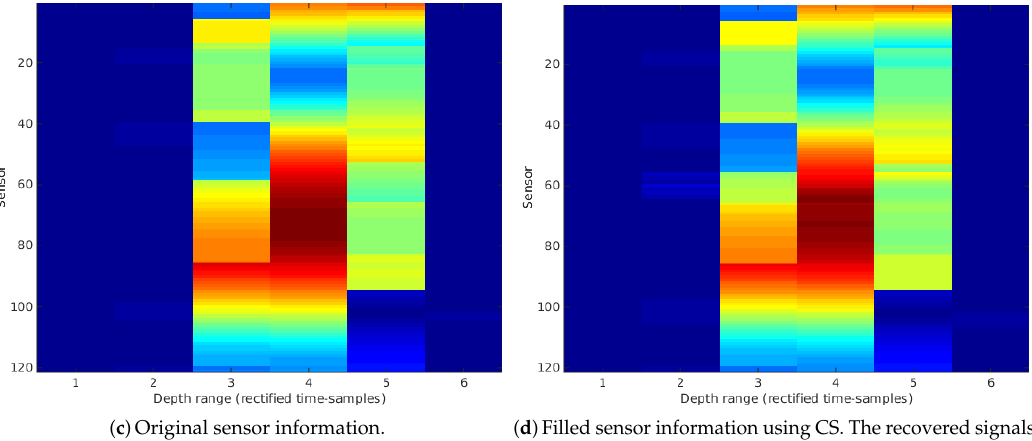
Figure 9. Example of the application of Compressed Sensing (CS) on a larger gap of sensor information. This signal matrix corresponds to the rectified sensor-channel information where the array manifold vector is shifted with the time-delay/phase parameter for the corresponding direction/voxel